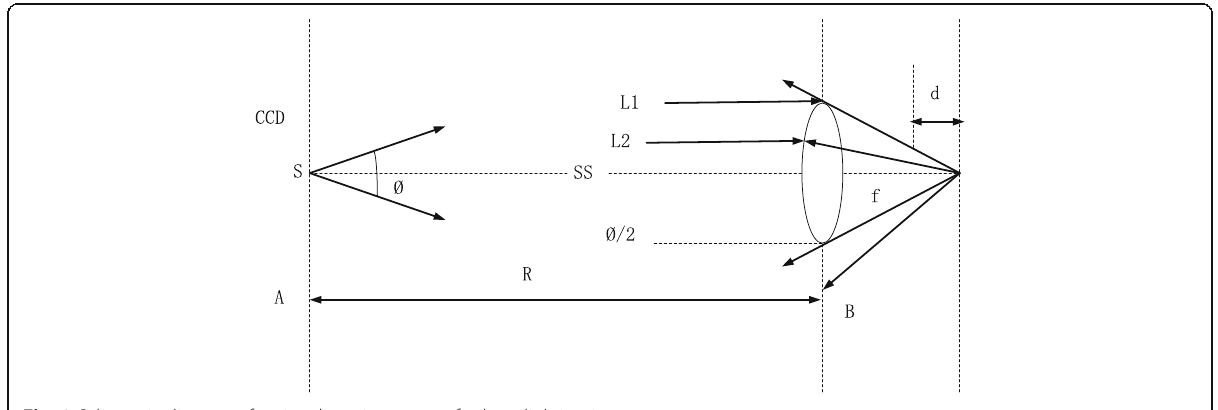
Fig. 2 Schematic diagram of active detection system for laser lighting